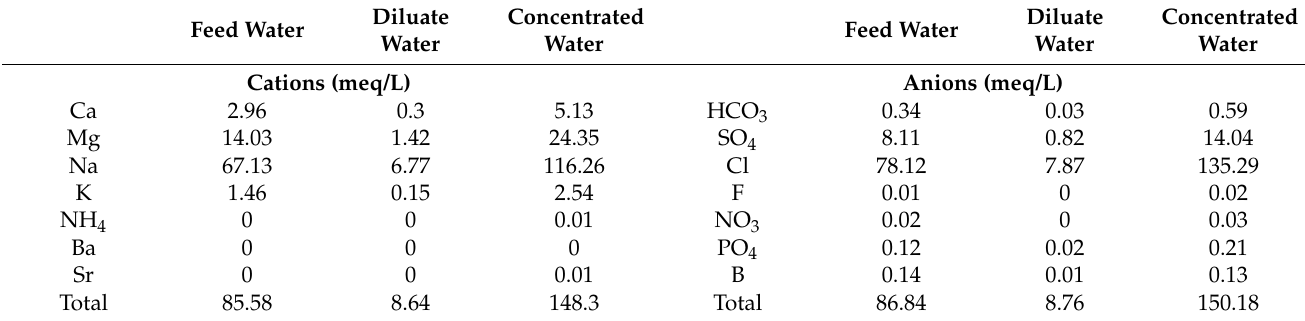
Table 8. Mass Balance of the experiments at 5000 mg/L, 35 ◦ C, and 20